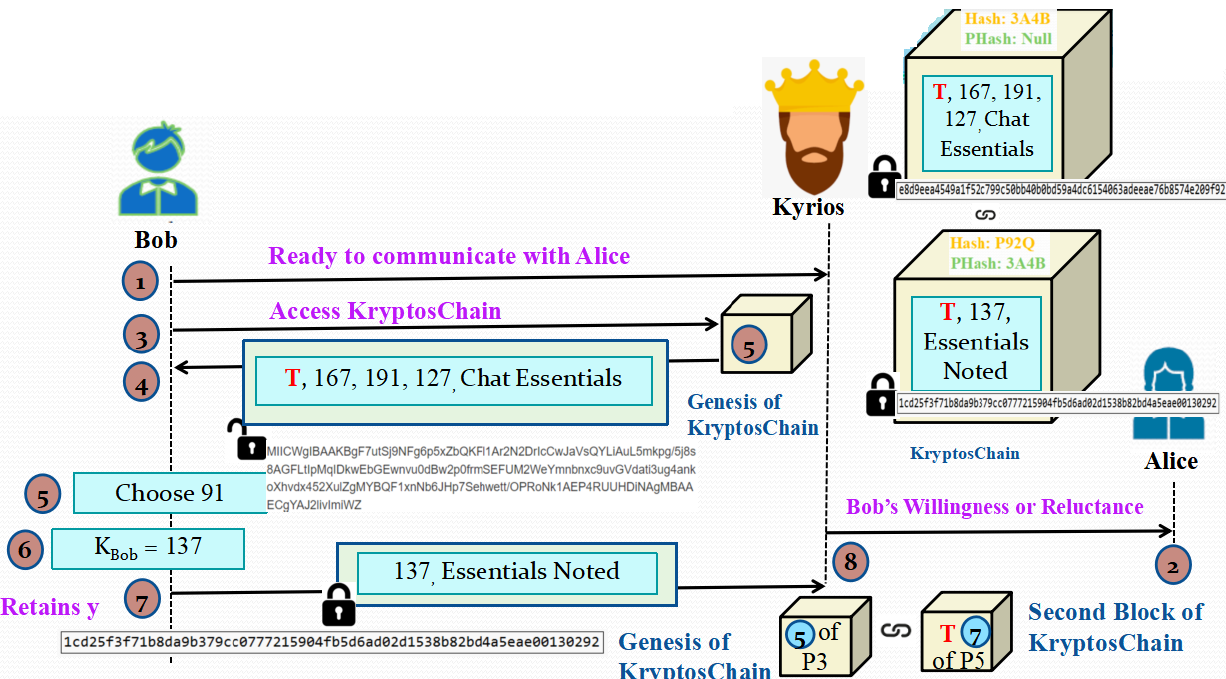
Figure 15. Demonstration of Phase 5: Second Block Generation Process.